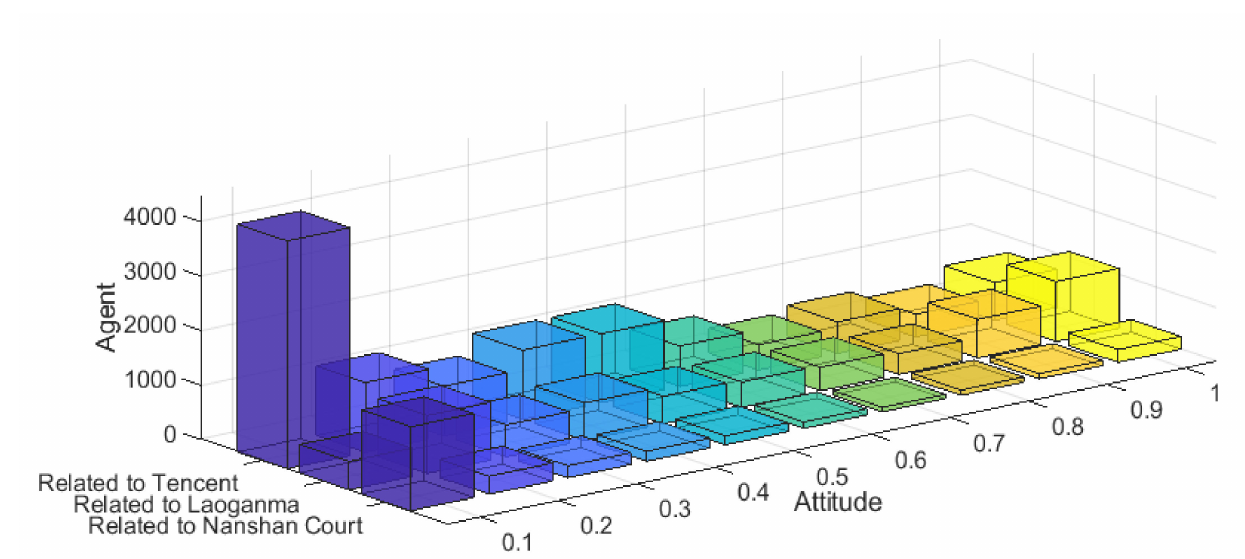
Figure 24. The distribution chart of public